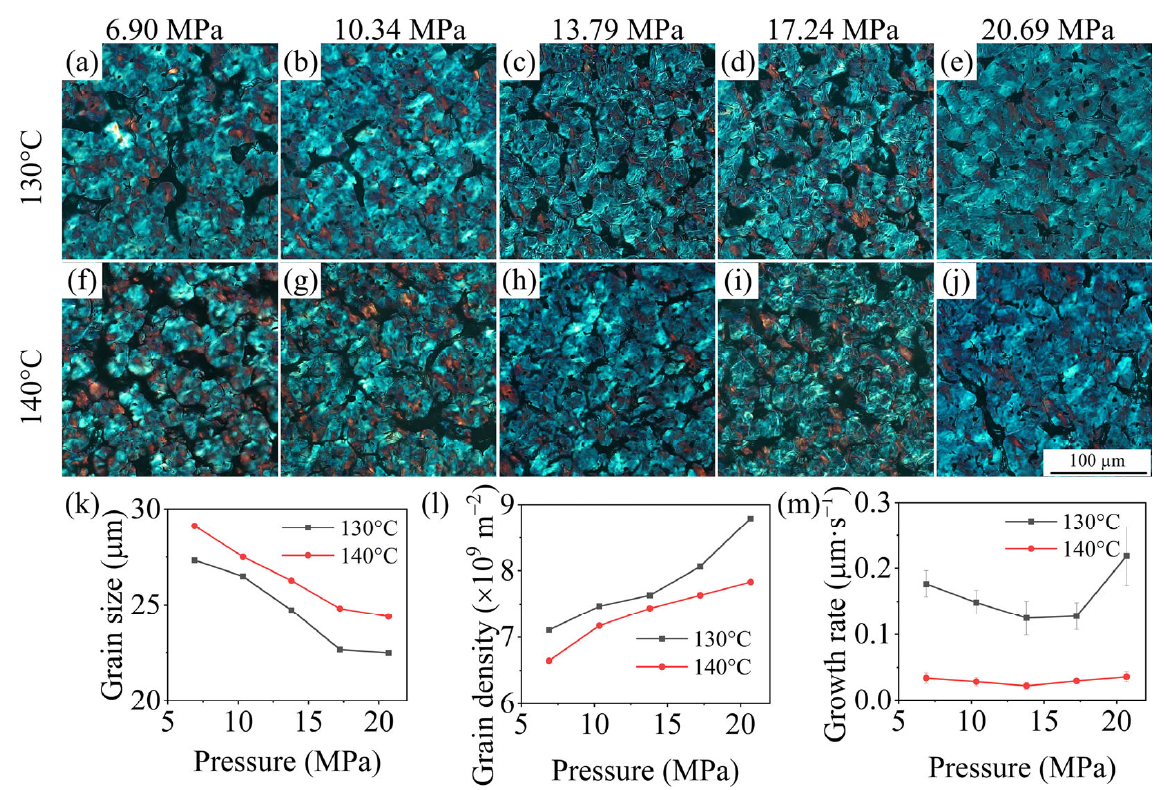
Figure 5. ( a – j ) POM photos of PP/GN nanocomposites, evolution of ( k ) Grain size, ( l ) grain density and ( m ) grain growth rate with N 2 for PP/GN isothermal crystallization at 130 and 140 °C.